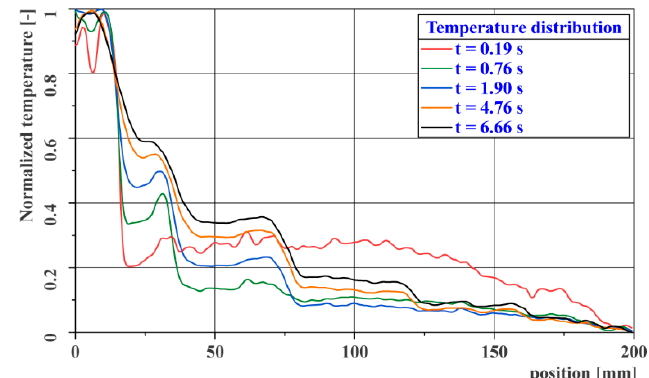
Figure 10. Course of temperature distribution along the longitudinal axis of the gauge.